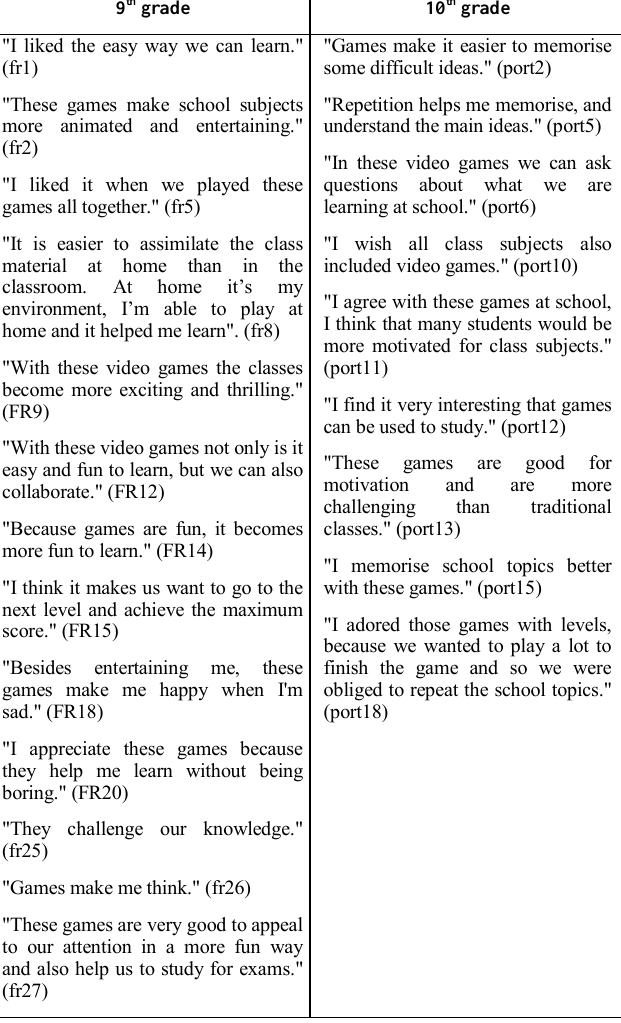
Table 12. Aspects of video games that are most appreciated by